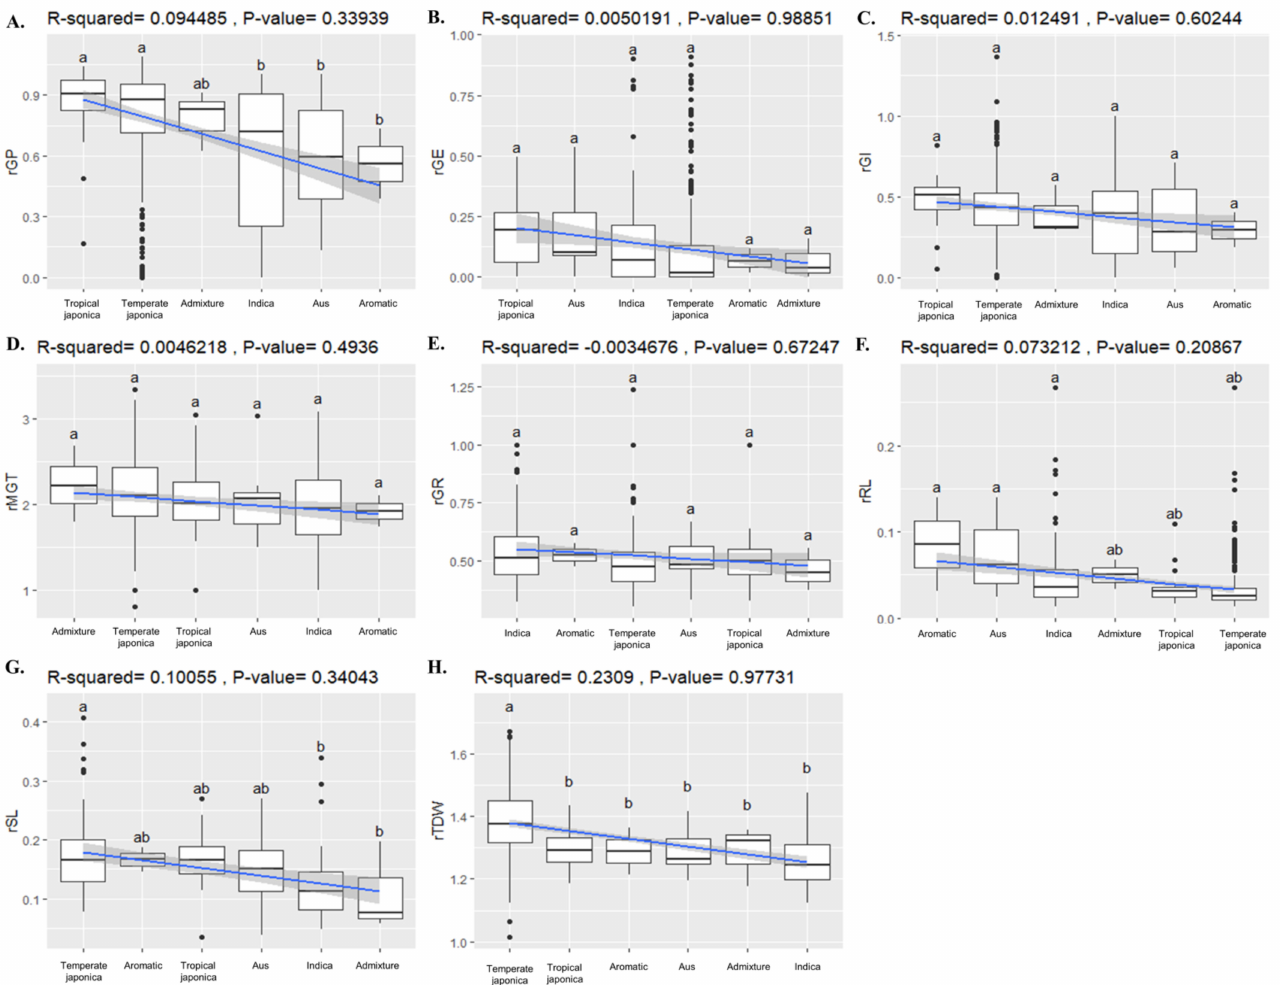
Figure 6. Test/Control ratio of eight major plant parameters distribution group by ecotypes. ( A – H ) Relative variations of salt tolerance-related traits among the classified ecotypes, indicating significant level by statistical test. The order of classified ecotypes was sorted (from left to right) by their relative/statistical mean value (from highest to lowest) of each trait. Each parameter was drawn in a boxplot using 417 rice accession for which phenotype data were surveyed. For each parameter, the analysis was performed at a significant level of p -value < 0.05, and the values were compared among the classified rice ecotypes using Scheffe’s test and indicated on the boxplot of each ecotype. Abbreviations: rGP, relative germination percentage; rGE, relative germination energy; rGI, relative germination index; rGMT, relative germination mean time; rGR, relative germination rate; rRL, relative root length; rSL, relativce shoot length; rTDW, relative total dry